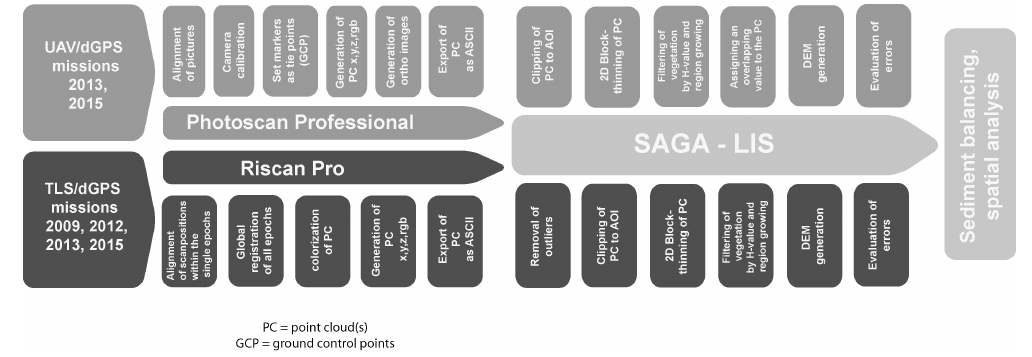
Figure 5. Workflow of the processing steps in PhotoScan Pro, RiscanPro, and LIS/SAGA